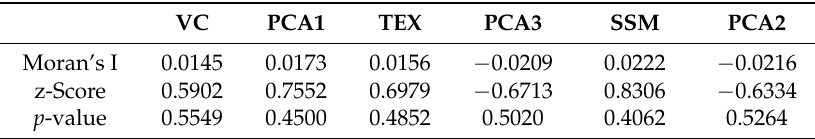
Table 2. The global Moran’s I of training samples under the neighborhood search distance of 20,000 m by ArcMap.